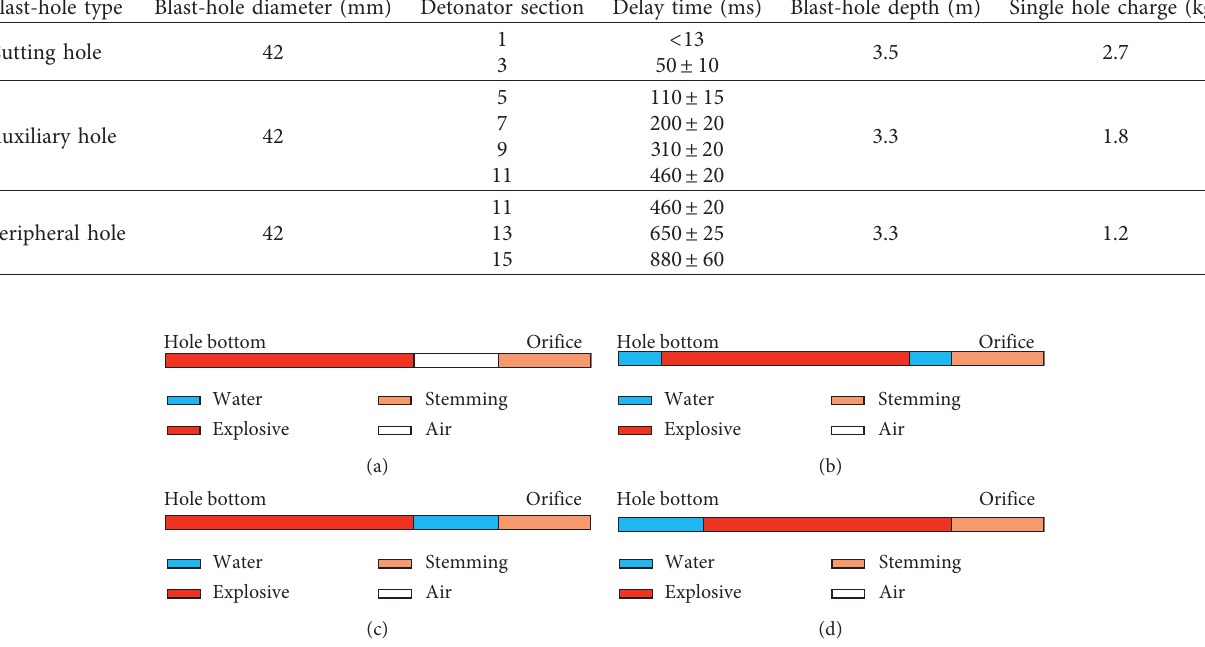
Figure 4: Charge structure. (a) Conventional charge. (b) Water interval charge at both ends. (c) Water interval charge at the orifice. (d) Water interval charge at the hole